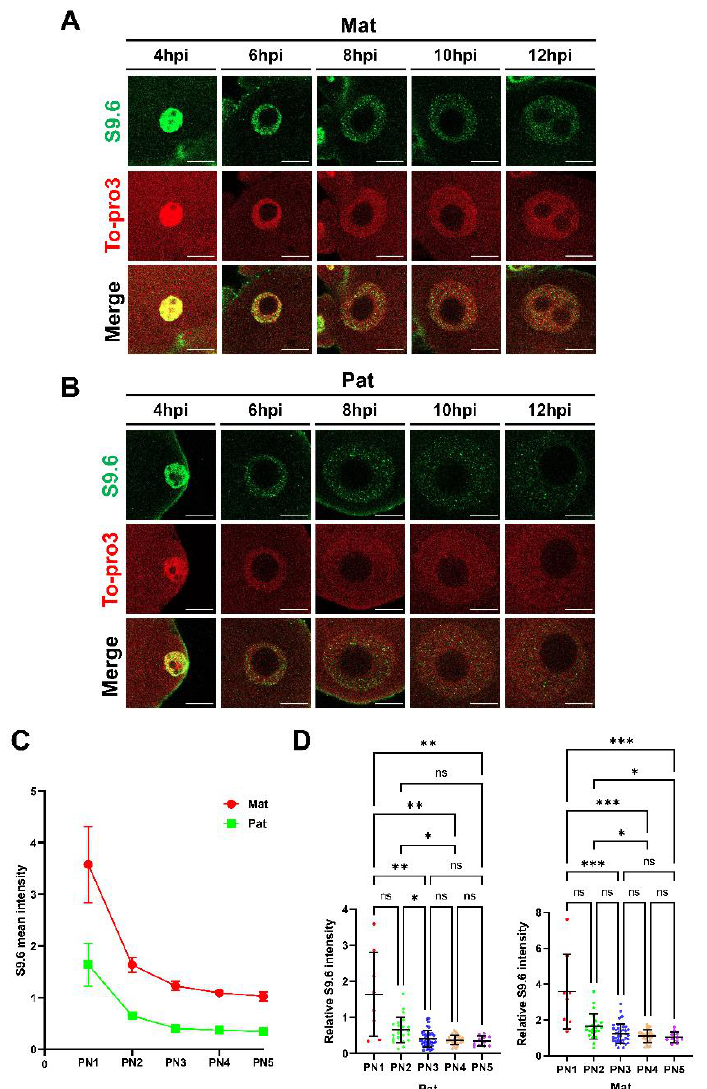
Figure 3. Dynamic R-loop levels through pronuclear stages (PNs). ( A ) Single confocal optical section images of each maternal pronucleus stage. Immunofluorescence detection of the R-loop (S9.6 antibodies, green), DNA (To-pro3, red), and merged images of these two channels (merged). ( B ) Single confocal optical section images of each paternal pronucleus stage. Immunofluorescence detection of the R-loop (S9.6 antibodies, green), DNA (To-pro3, red), and merged images of these two channels (merged). All scale bars = 10 µM. ( C ) Comparison of relative S9.6 signal intensities in maternal (red) and paternal (green) pronucleus from PN1 to PN5 stages. Each plot indicates the mean values of the relative S9.6 signal intensities of each PN. ( D ) Quantification of relative S9.6 signal intensities in the maternal ( left ) and paternal ( right ) pronuclei. PN1; n = 8, PN2; n = 23, PN3; n = 38, PN4; n = 28, PN5; n = 11. The experiment was independently replicated three times. Statistical analysis was performed using one-way ANOVA with Tukey ’ s test and Kruskal – Wallis test. M, paternal pronucleus; P, paternal pronucleus. Error bars represent standard deviation. p -value: * p < 0.05, ** p < 0.01, *** p < 0.001; center values, mean; ns, not significant.